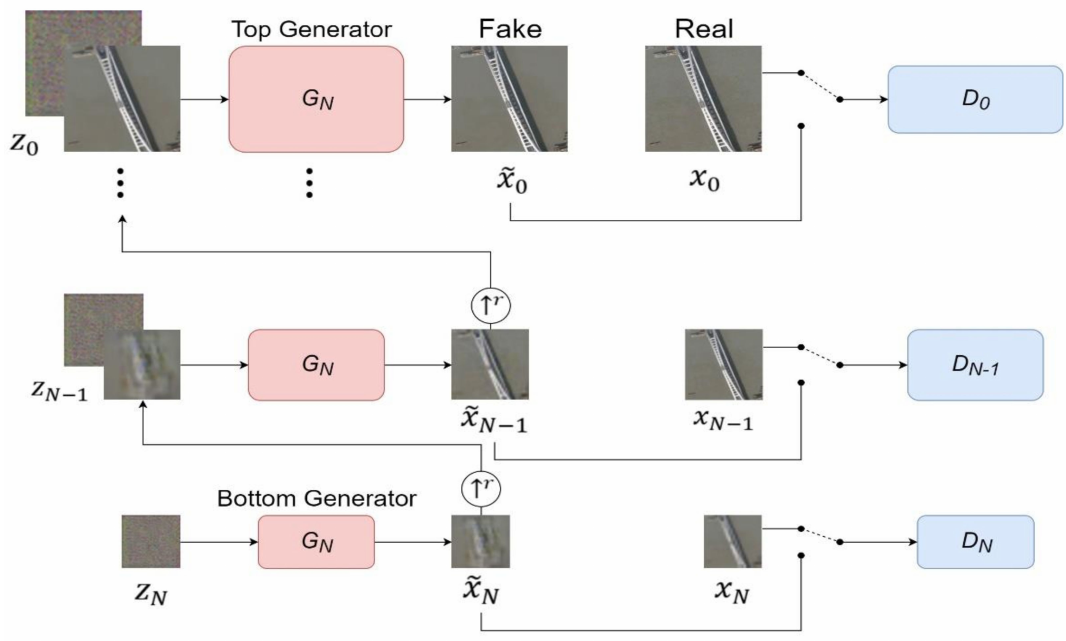
Figure 2. Framework structural diagram of single natural image Generative Adversarial Networks